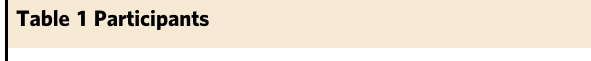
Sociodemographic variables